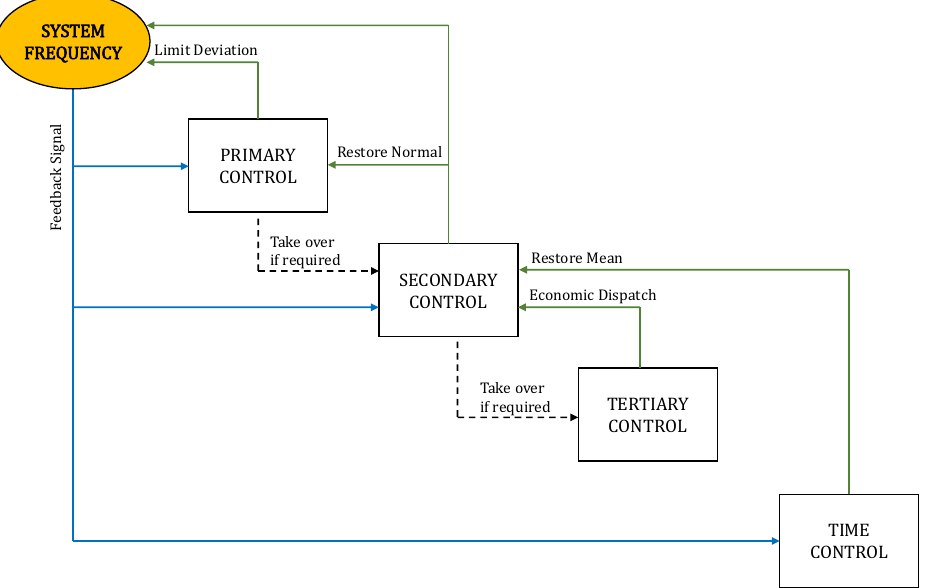
Figure 2. Example control hierarchy for load frequency control [2].